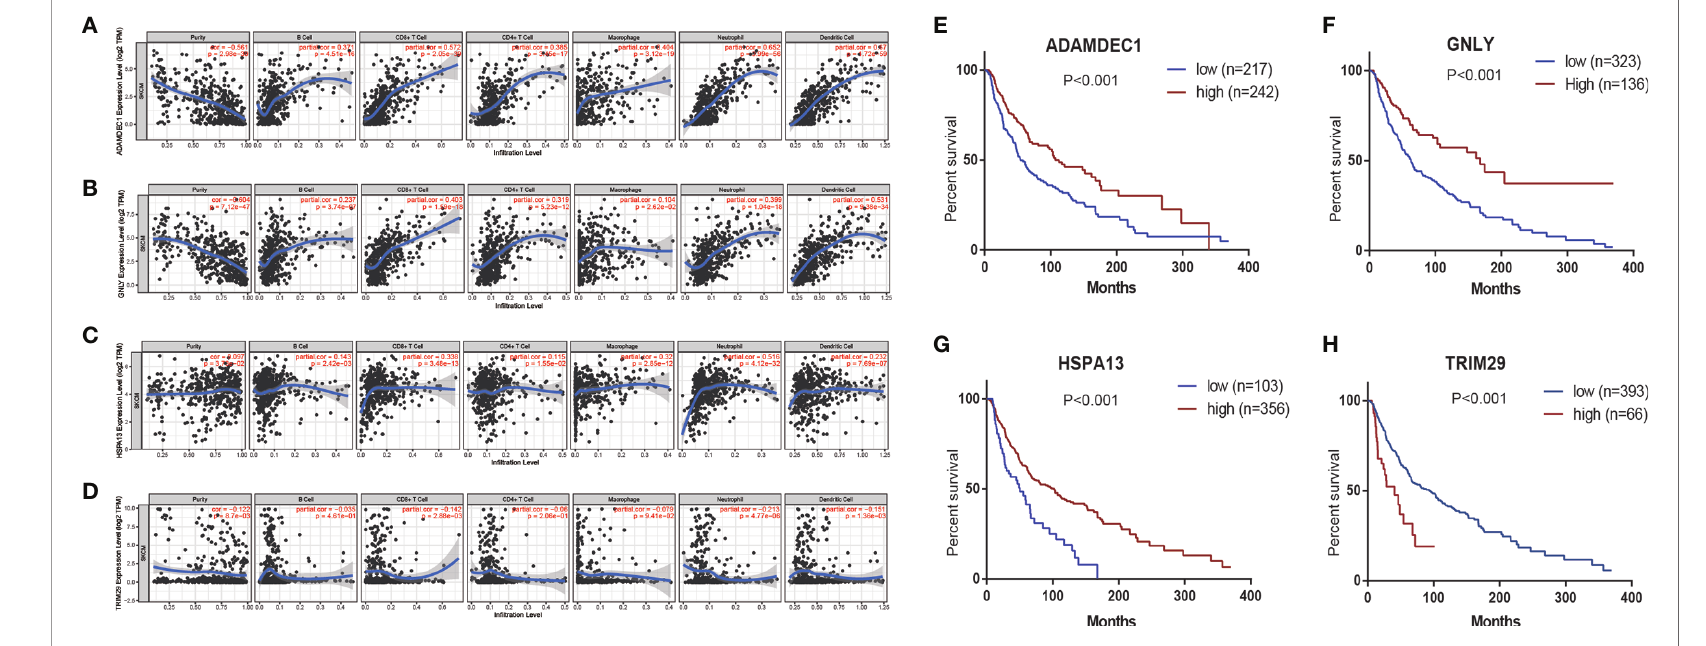
FIGURE 7 | The correlation between prognostic genes expression and immune cell in fi ltration in CM (TIMER database). The correlation between the abundance of immune cell and the expression of (A) ADAMDEC1; (B) GNLY; (C) HSPA13; (D) TRIM29. Prognostic values of (E) ADAMDEC1, (F) GNLY, (G) HSPA13, (H) TRIM29 in TCGA